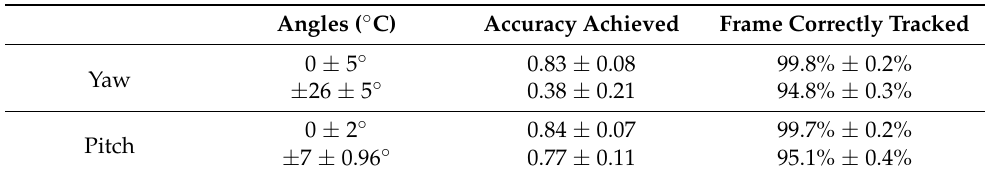
Table 2. Percentage of frames where the face was correctly detected and the accuracy achieved with respect to different facial orientation angles.